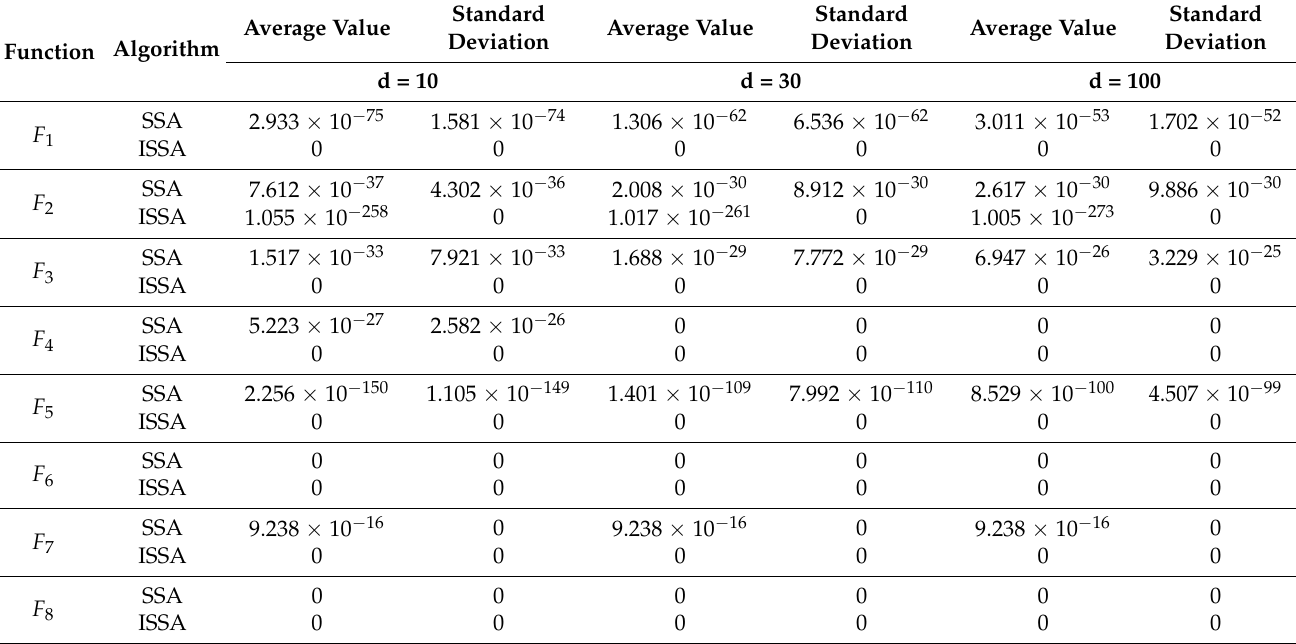
Table 2. Results of algorithm-optimization benchmark-test